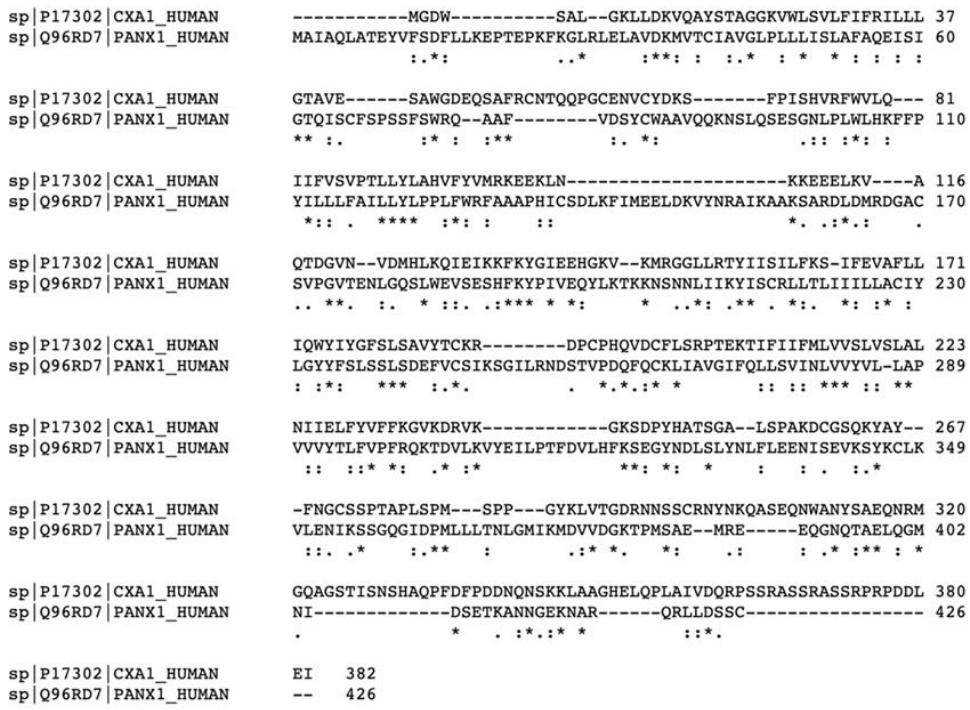
Figure 2. Sequence alignment of human Cx43 (also known as CXA1) and Panx1, showing 23.01% homology in their sequences. Created with Uniprot.org, accessed on 17 August 2022. An * (asterisk) indicates positions which have a single, fully conserved residue. A : (colon) indicates conservation between groups of strongly similar properties. A . (period) indicates conservation between groups of weakly similar properties